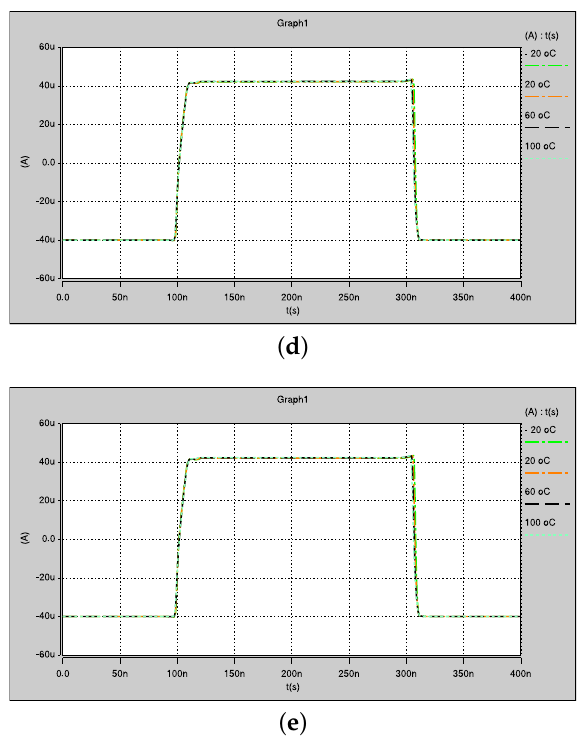
Figure 9. Temperature variations of Figure 6 for the cases: ( a ) TT; ( b ) SF; ( c ) FS; ( d ) SS; and ( e ) FF.